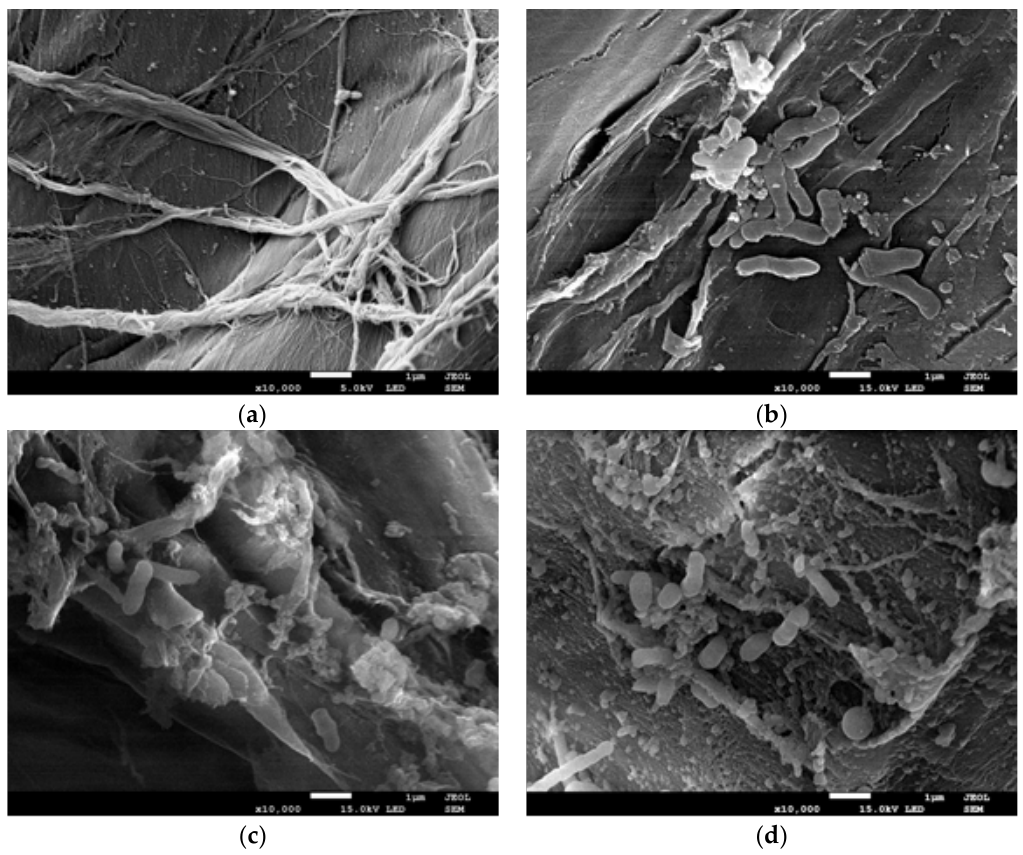
Figure 6. Scanning electron microscopy ( SEM ) micrographs of unimmobilized loofah sponge ( a ), biofilm formed by Planococcus sp. S5 cells onto loofah sponge before naproxen degradation ( b ), after decomposition of the first dose of naproxen (6 mg/L) ( c ) and the second dose of the drug (6 mg/L) ( d ).